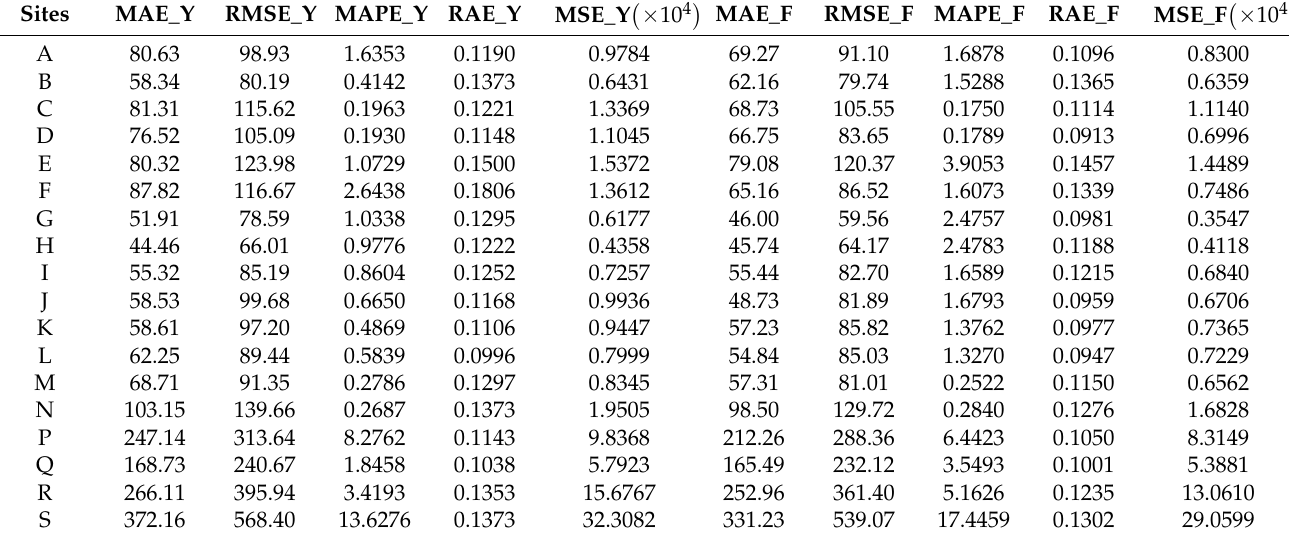
7 GHz horizontal polarization scan for all sites after denoising and applying the algorithm to all sites, including those without the potential to cause interference. Table 7. Error analysis for the estimated normal distribution (Y) and the estimated fitness curve (F), where the first five columns describe the error in the PDF and the last five columns describe the errors in the fitness curve for the 6 GHz vertical polarization.